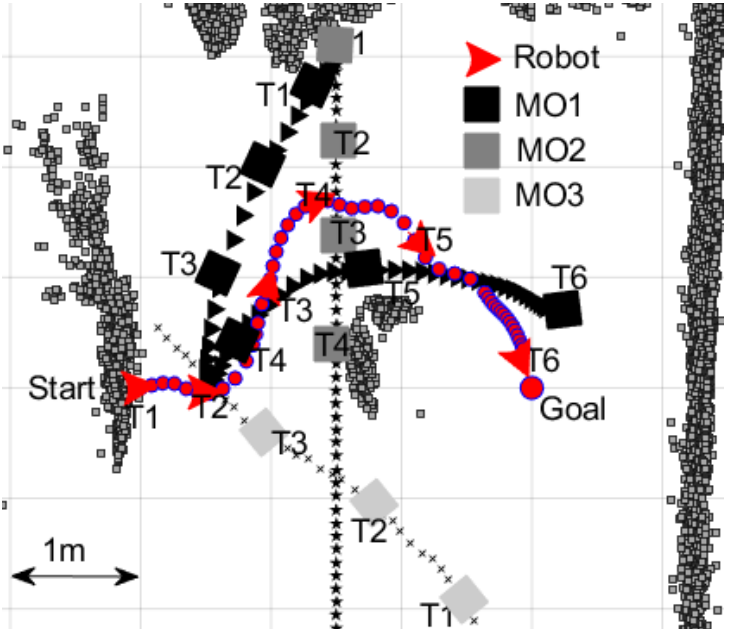
Figure 11. The robot’s observed path in Experiment 5. The locations of the robot and moving obstacles (MO1–MO3) are shown at six different time instants